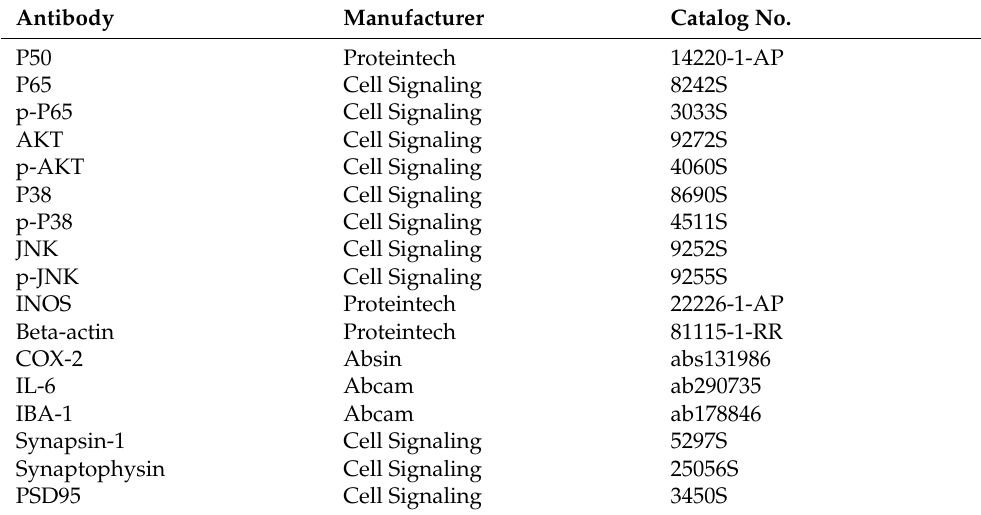
Table 1. List of antibodies used in this